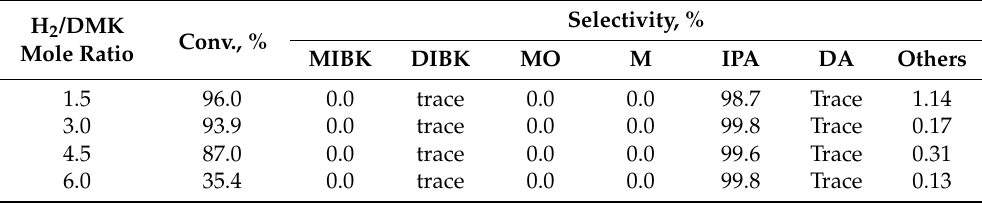
Table 2. Effect of hydrogen to acetone mole ratio on conversion and selectivity at 100 ◦ C. Selectivity, % H 2 /DMK Conv., % Mole Ratio MIBK DIBK